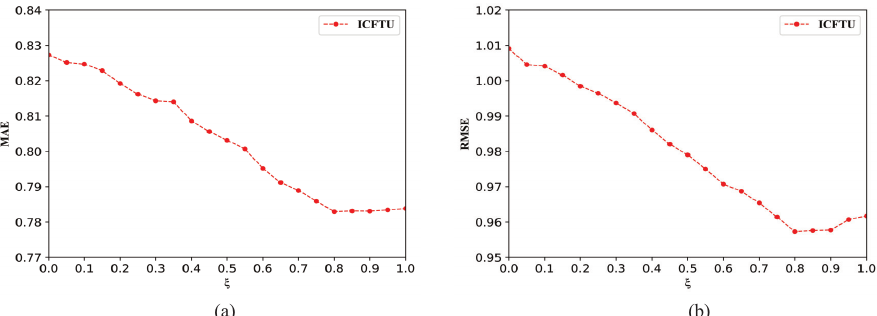
Figure 8. The influence of the model weights ξ and µ on the proposed method: ( a ) of MAE; ( b ) of RMSE.